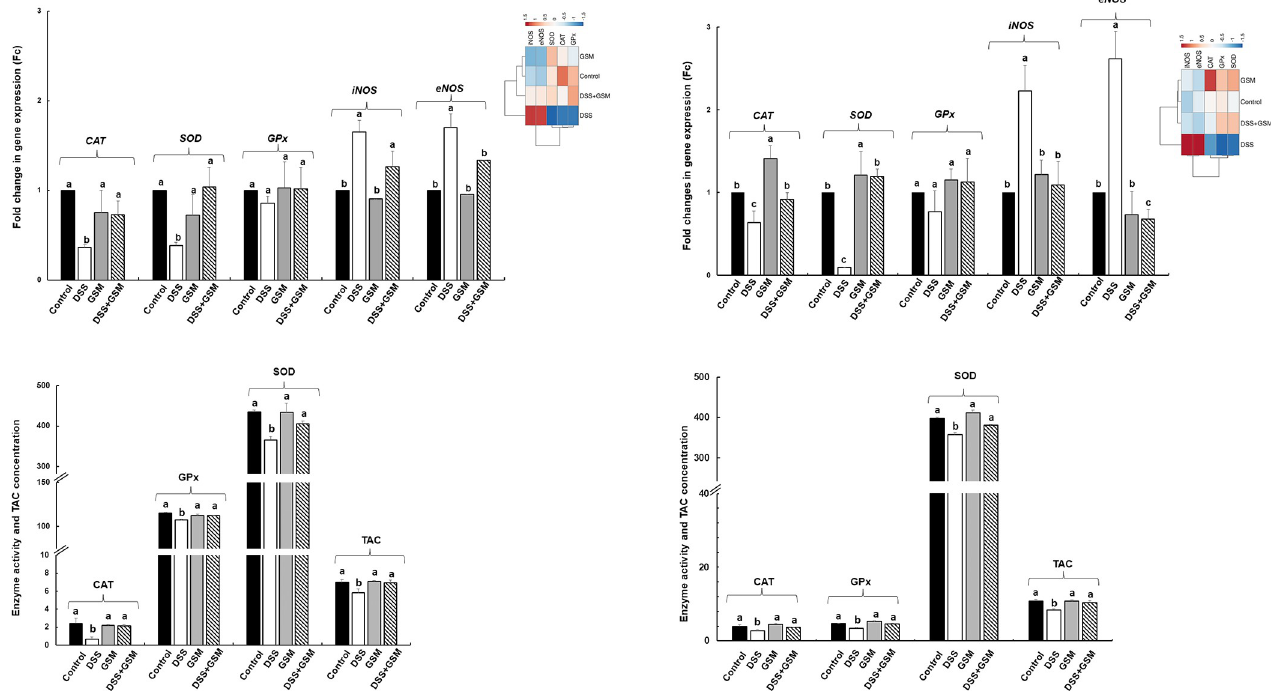
Fig 5. Effect of DSS and dietary GSM treatment on antioxidant gene expression in colon (A), and mesenteric lymph nodes (B) and on enzyme activity and TCA in colon (C) and lymph nodes (D). Unchallenged and DSS-treated pigs were assigned for 30 days to a Control diet (Control and DSS groups) or 8% GSM diet (GSM and DSS + GSM groups). At the end of the experiment, colon and lymph nodes samples from all animals (n = 5) were collected and analysed for gene expression (qPCR), enzymes activity and total antioxidant capacity (TCA). The enzyme activities were expressed as: μ mol/min/g tissue (CAT and GPx), U/g tissue (SOD), μ mol/g tissue (TAC). Results are presented as means ± standard errors. a, b, c = Histograms for each group with unlike superscript letters were significantly different ( p < 0.050). The heatmap (upper right panels) represents gene expression levels in colon (A-right panel) and mesenteric lymph nodes (B–right panel). The blue and red colours correspond to low and high gene expression, respectively.